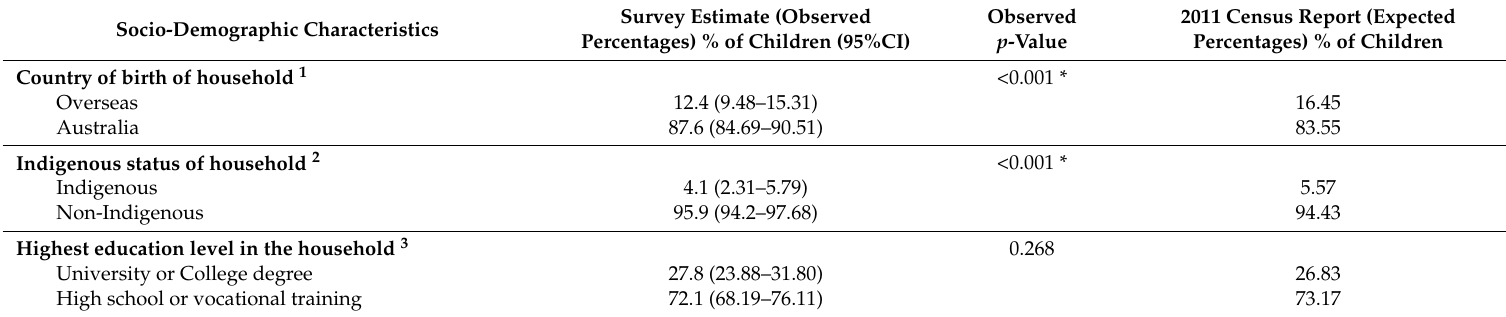
Table 3. Population benchmark comparison of demographic characteristics of Lithgow from ABS census 2011